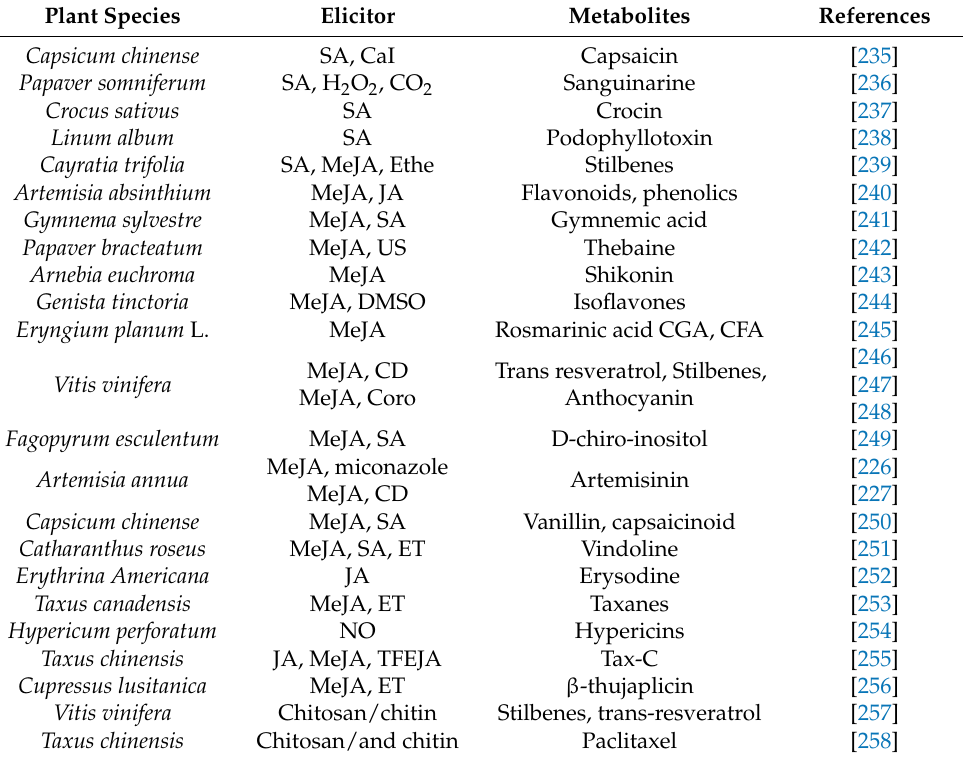
Table 1. Specialized metabolites enhanced by the application of cellular signaling compounds in plant suspension cell